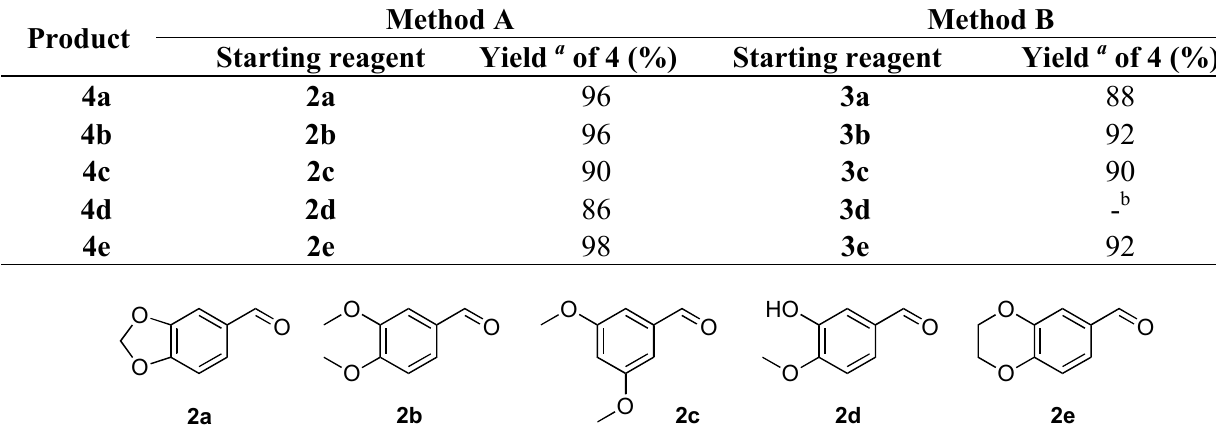
Table 1. Results for the solvent-less preparation of 5-arylmethylene-1-methyl-2-thioxo imidazolin-4-ones 4(a-e) under microwave from aldehydes 2(a-e) (Method A) or aldimines 3(a-e) (Method